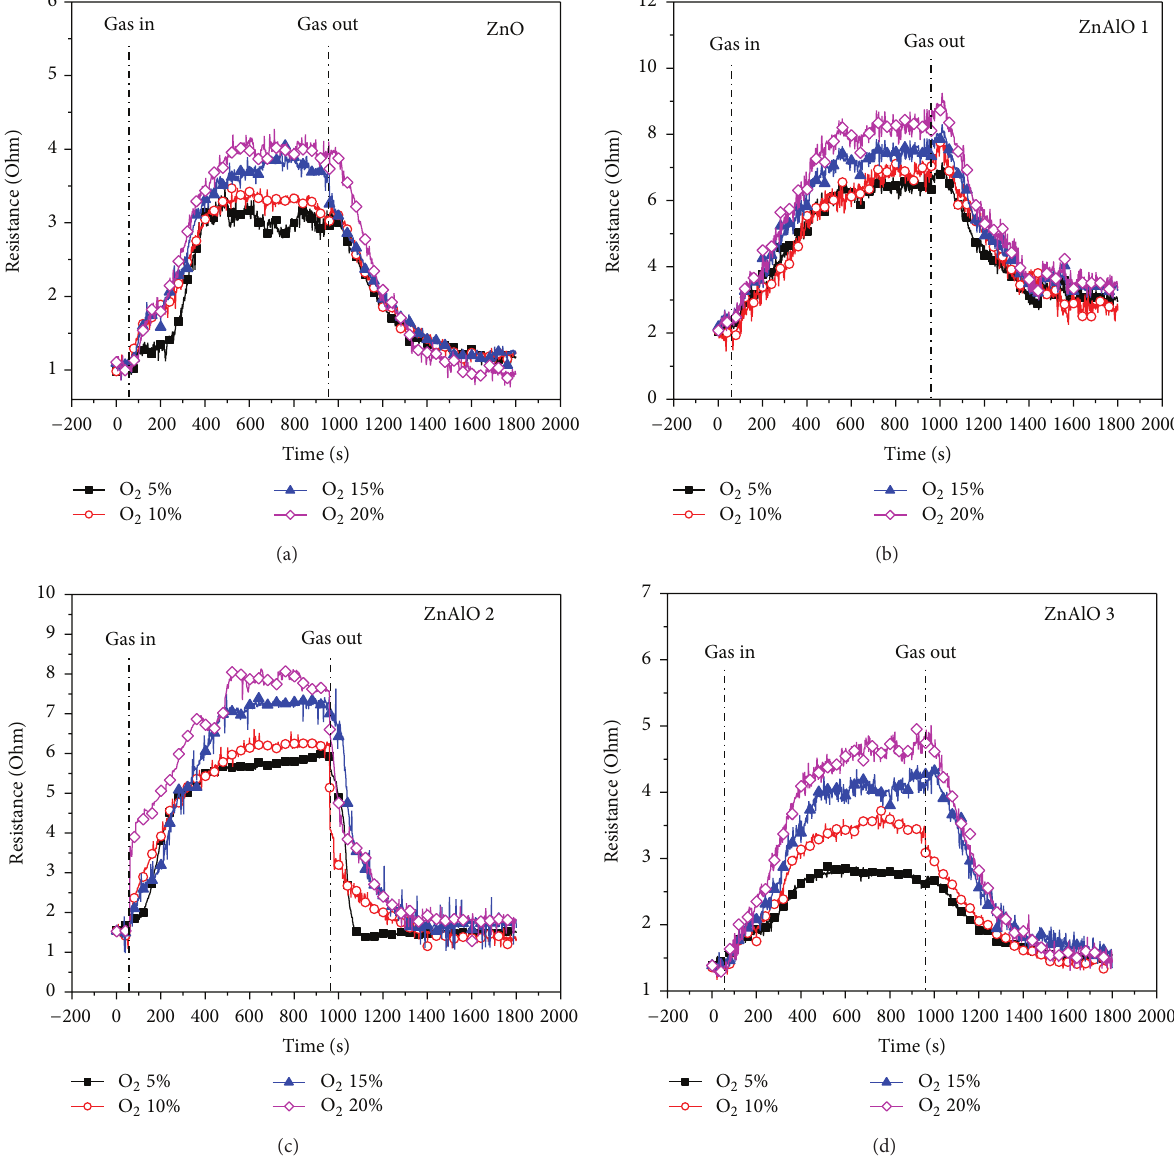
Figure 5: The effect of aluminum content on the resistance of zinc aluminum oxide gas sensor upon exposure to the various concentrations of oxygen at an operating temperature of 200 ∘